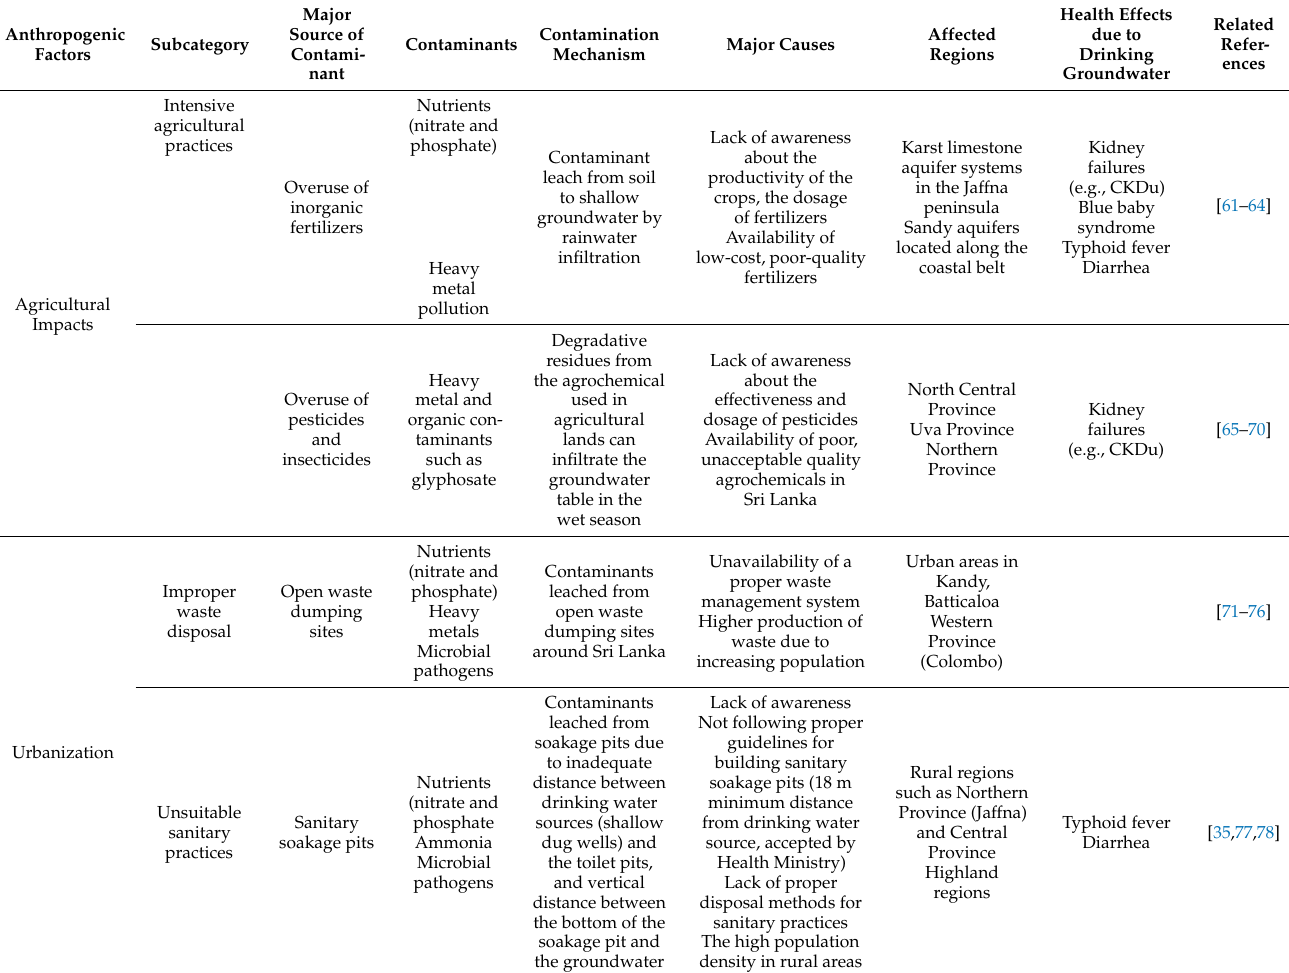
Table 3. Anthropogenic activities affecting the groundwater quality in different regions of Sri